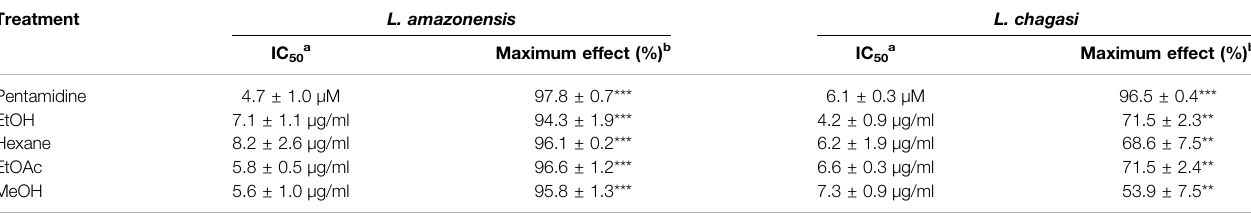
TABLE 3 | Effects of pentamidine, EtOH extract; hexane, EtOAc, MeOH fractions of propolis from the semi-arid region of Bahia, Brazil against promastigote forms of L. amazonensis and L. chagasi.